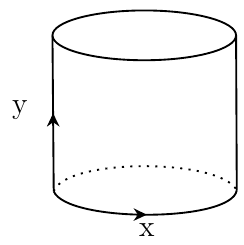
Figure 3 . Space-time cylinder, with x ∼ x + R